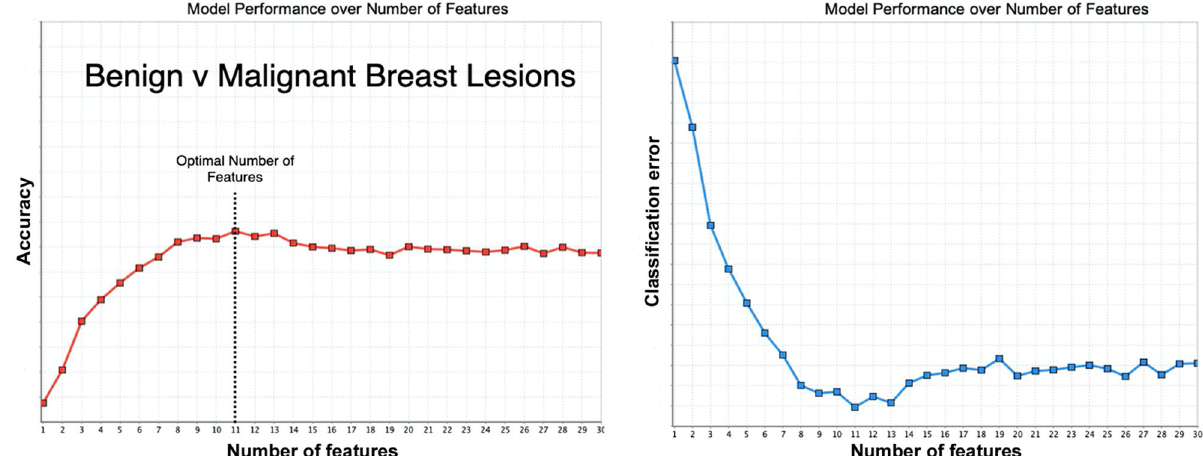
Fig. 1 Feature selection for radiomics. In this illustration, a model classi fi er is shown to differentiate benign from malignant breast lesions on imaging. Initially, a large number of radiomic features were computed and after removing the highly correlated features, the zero and near-zero variance features; a recursive feature elimination and reduction method was applied. The model performance illustrated here identi fi es11 features to be at the saturation point. The red curve (left) is showing accuracy versus number of features, while the blue curve (right) represents the model ’ s error function over the number of features. In this example, using 11 imaging features shows high accuracy while minimising the error function.